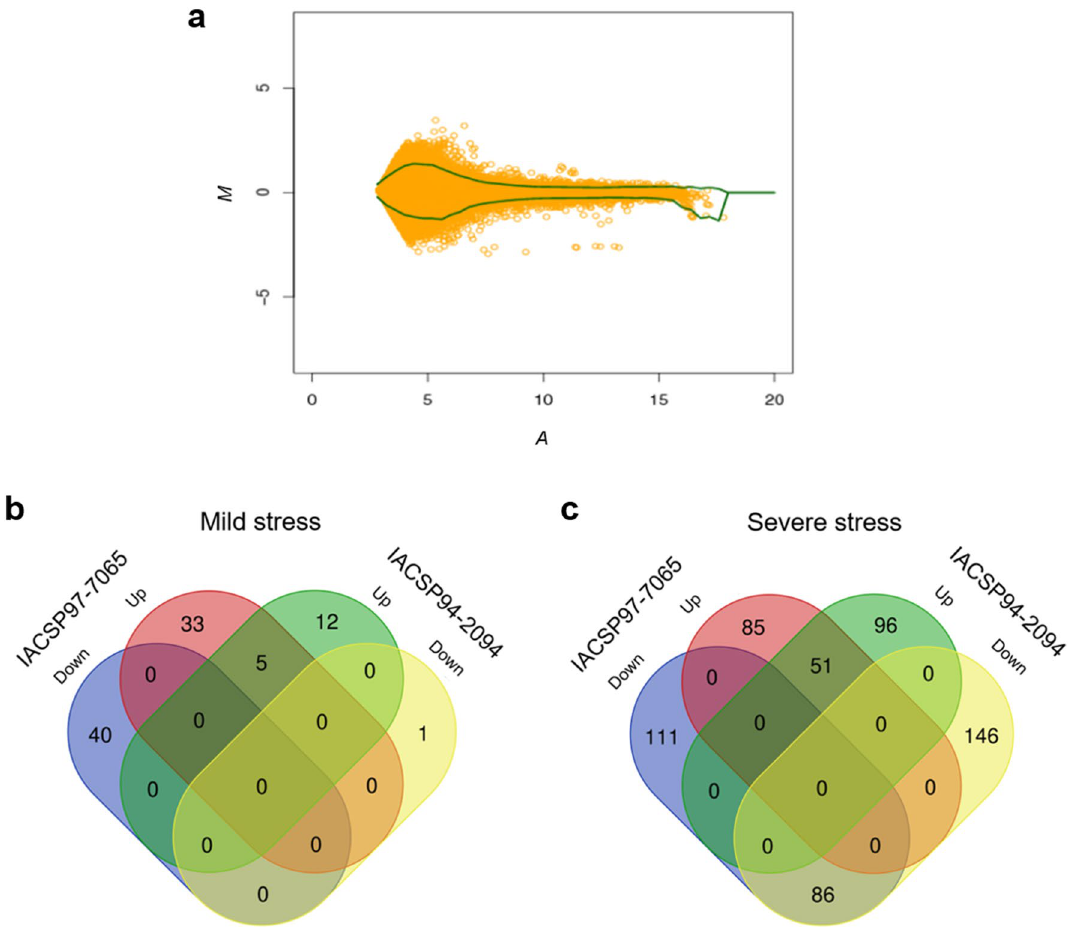
Figure 2. Differentially expressed genes in leaves of contrasting sugarcane genotypes. ( a ) MA-plot of the microarray experiment. The spots located outside the green line (confidence level set to p = 0.9) indicate differentially expressed genes (DEGs). Venn diagrams represent the DEGs identified as down- and up-regulated in leaves of sugarcane sensitive (IACSP97-7065) and tolerant (IACSP94-2094) genotypes under ( b ) mild and ( c ) severe drought stress.